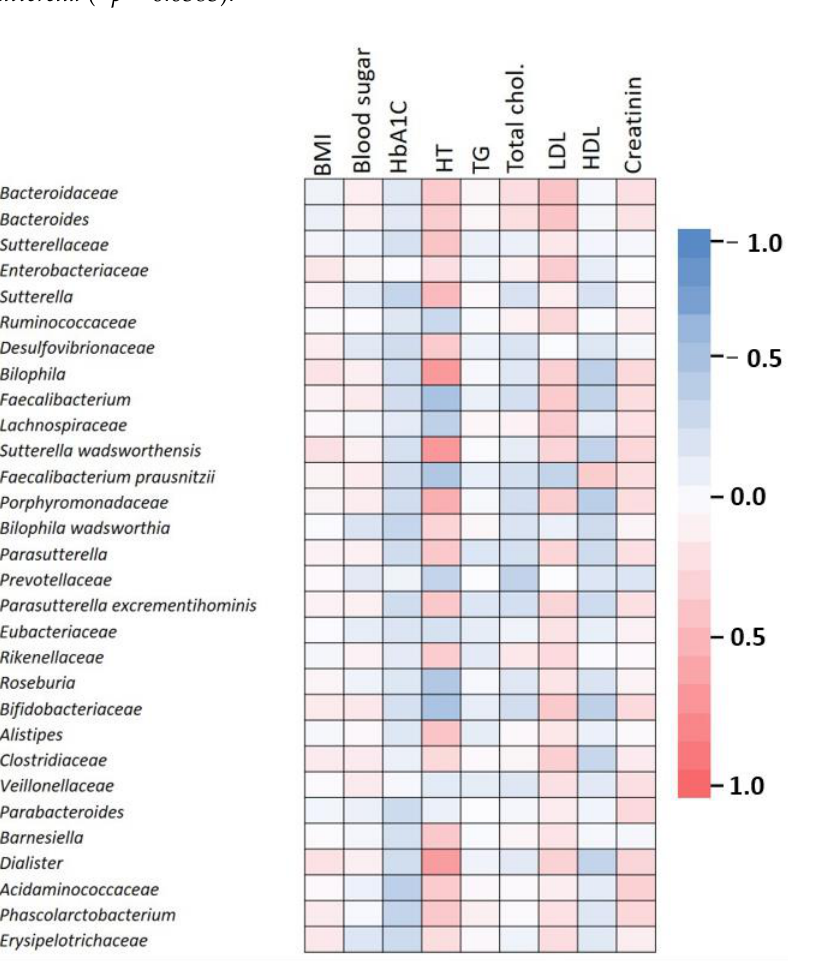
Figure 5. Correlations between clinical parameters and the top 30 OTUs in type 2 diabetes patients. The clinical parameters included BMI, hypertension (HT), hemoglobin A1c (HbA1c), serum choles- terol, triglycerides, HDL, LDL and creatinine. Pink indicates a positive correlation, blue indicates a negative correlation, while white indicates no correlation. Arterial hypertension was positively correlated with Bilophila (**** p < 0.0001), Barne- siella (* p = 0.0183), Dialister (**** p < 0.0001), Acidaminococcaceae (* p = 0.0267),